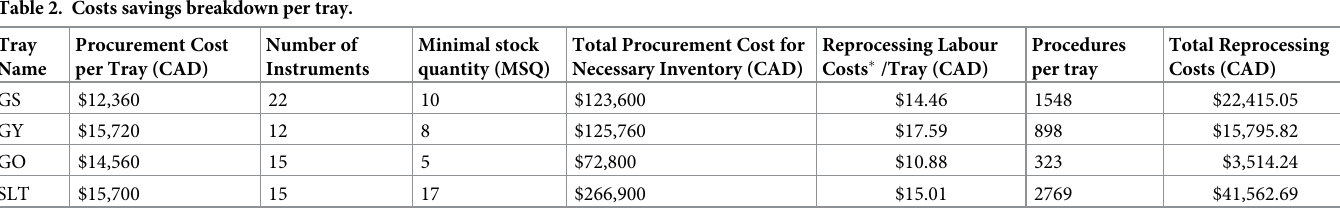
Table 2. Costs savings breakdown per tray.